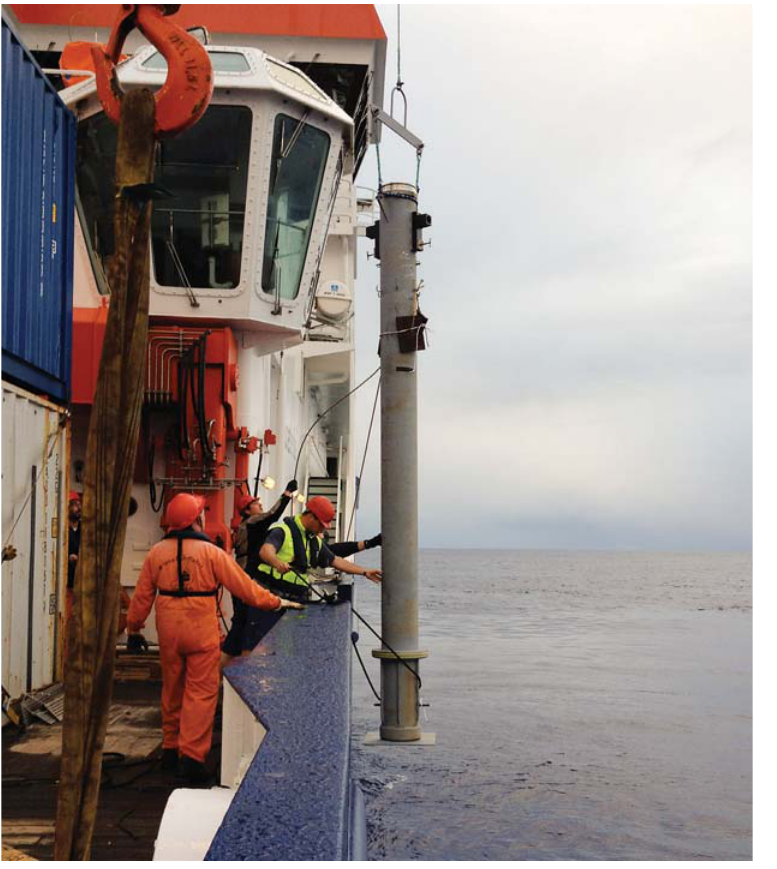
The downhole instrument string utilized components from Exp. 336 (osmotic pumps, coils of small bore sample